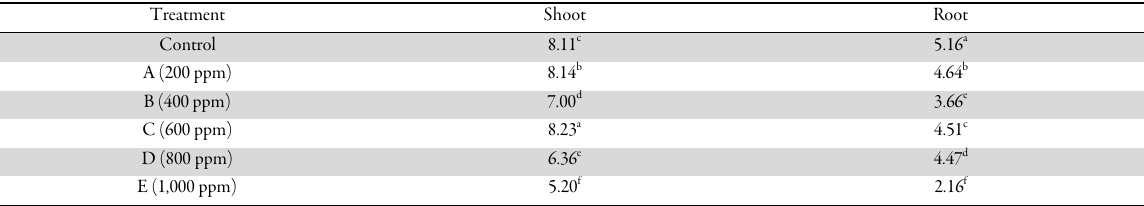
Fig. 5. Effect of different treatments of lead on the number of leaflets of Pityrogramma calomelanos Table 1. Plant biomass (g) of Pteris vittata after growing for 12 weeks in lead contaminated soil Treatment